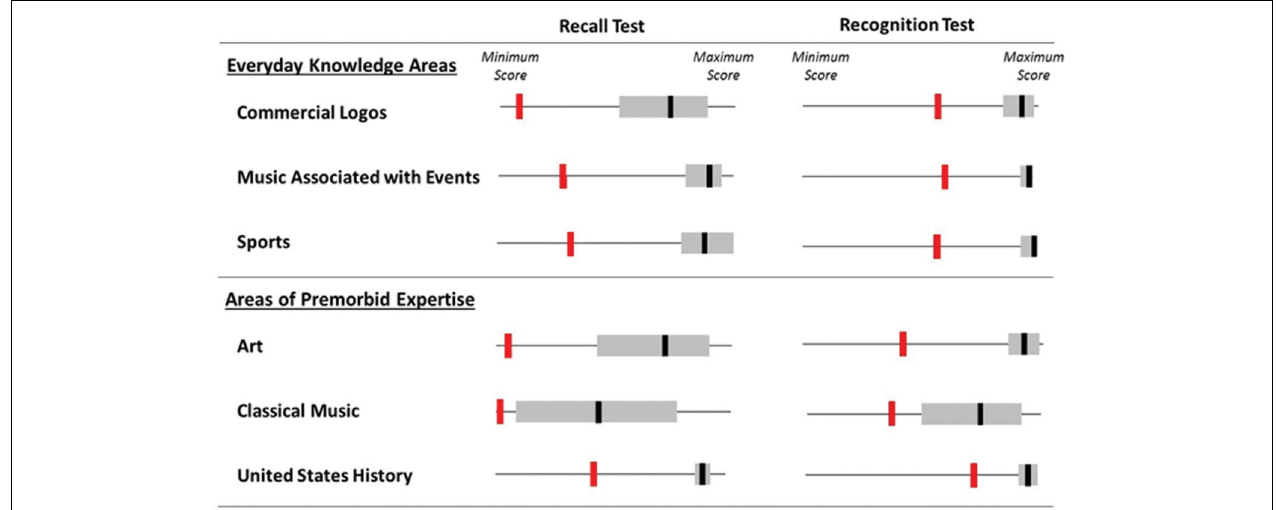
FIGURE 2 | LSJ’s and controls’ performance on everyday and expert knowledge domain recognition and recall tests. The red bar represents LSJ’s average score across two administrations of a test, the gray rectangle represents the control range, and the black bar represents the controls’ mean